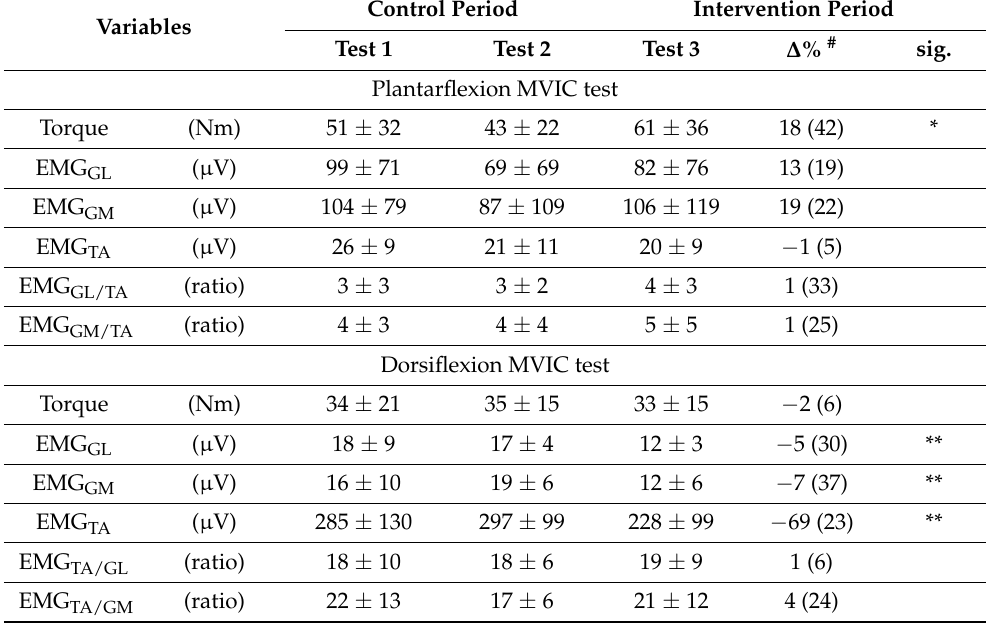
Table 1. The effects of the 12-week sand training on mechanical and function variables and body composition in DPN